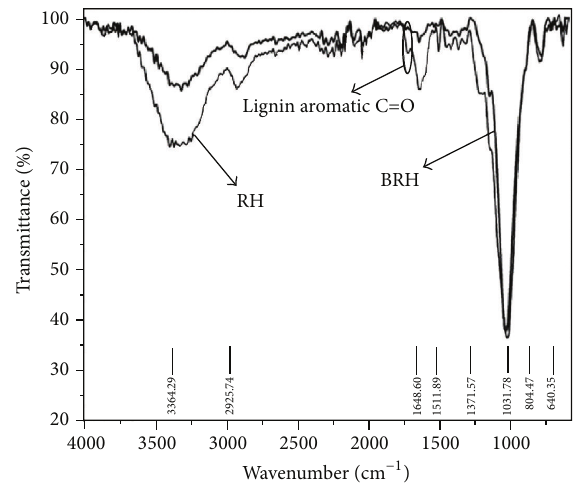
Figure 16: FTIR spectra of RH and BRH [49].